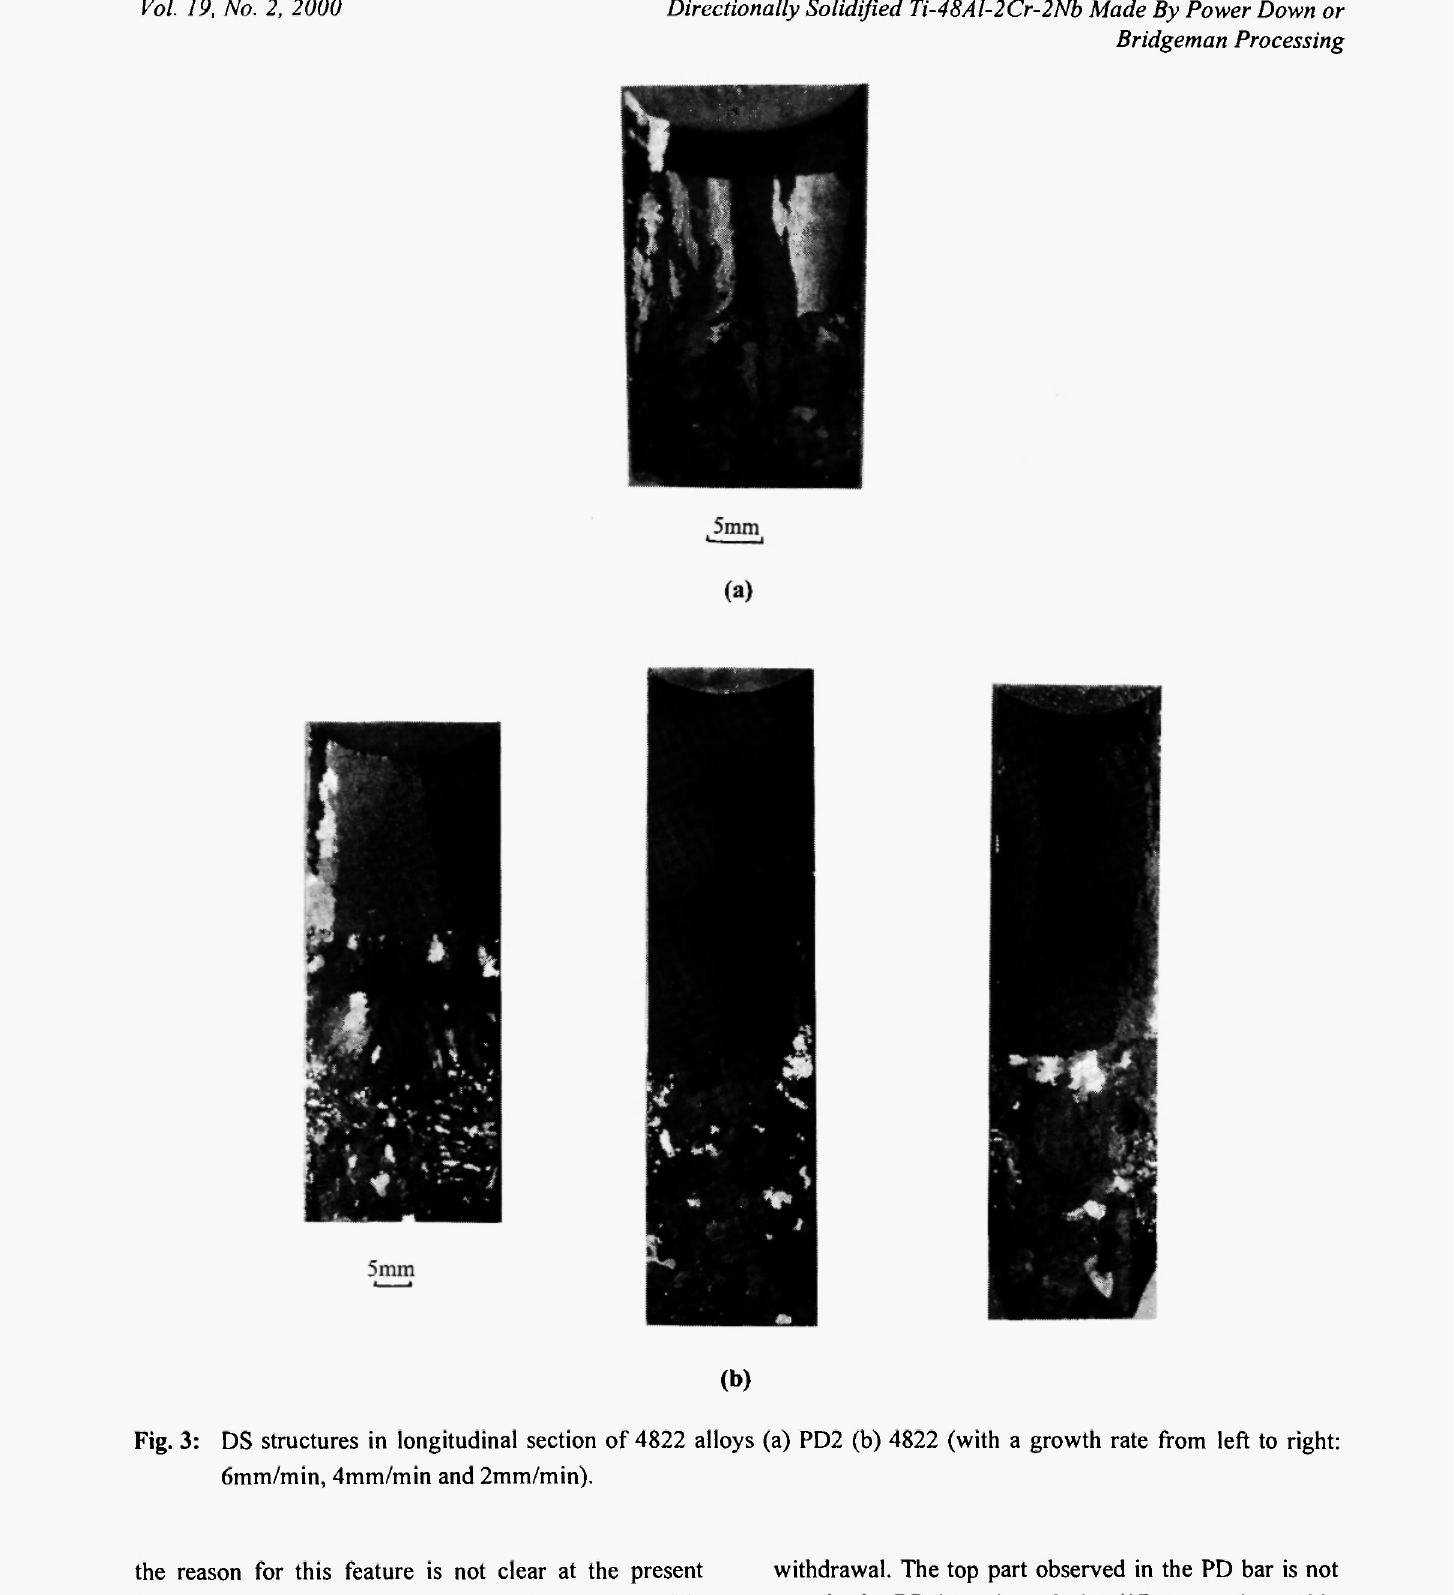
Fig. 3: DS structures in longitudinal section of 4822 alloys (a) PD2 (b) 4822 (with a growth rate from left to right: 6mm/min, 4mm/min and